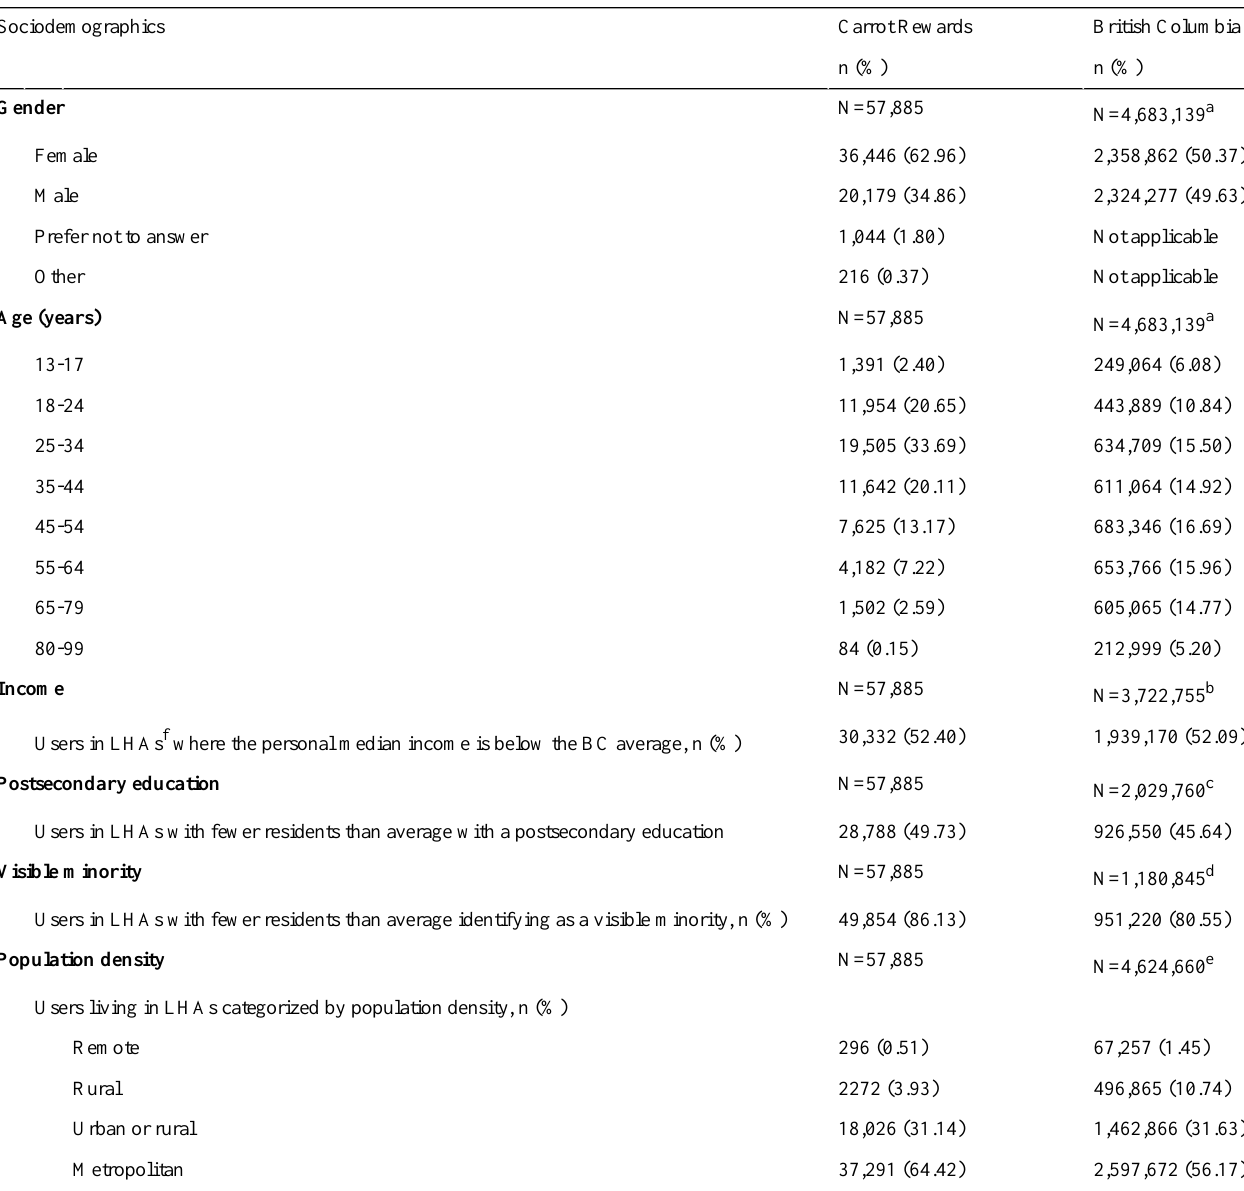
Table 1. Sociodemographics of Carrot Rewards users and British Columbians in general.